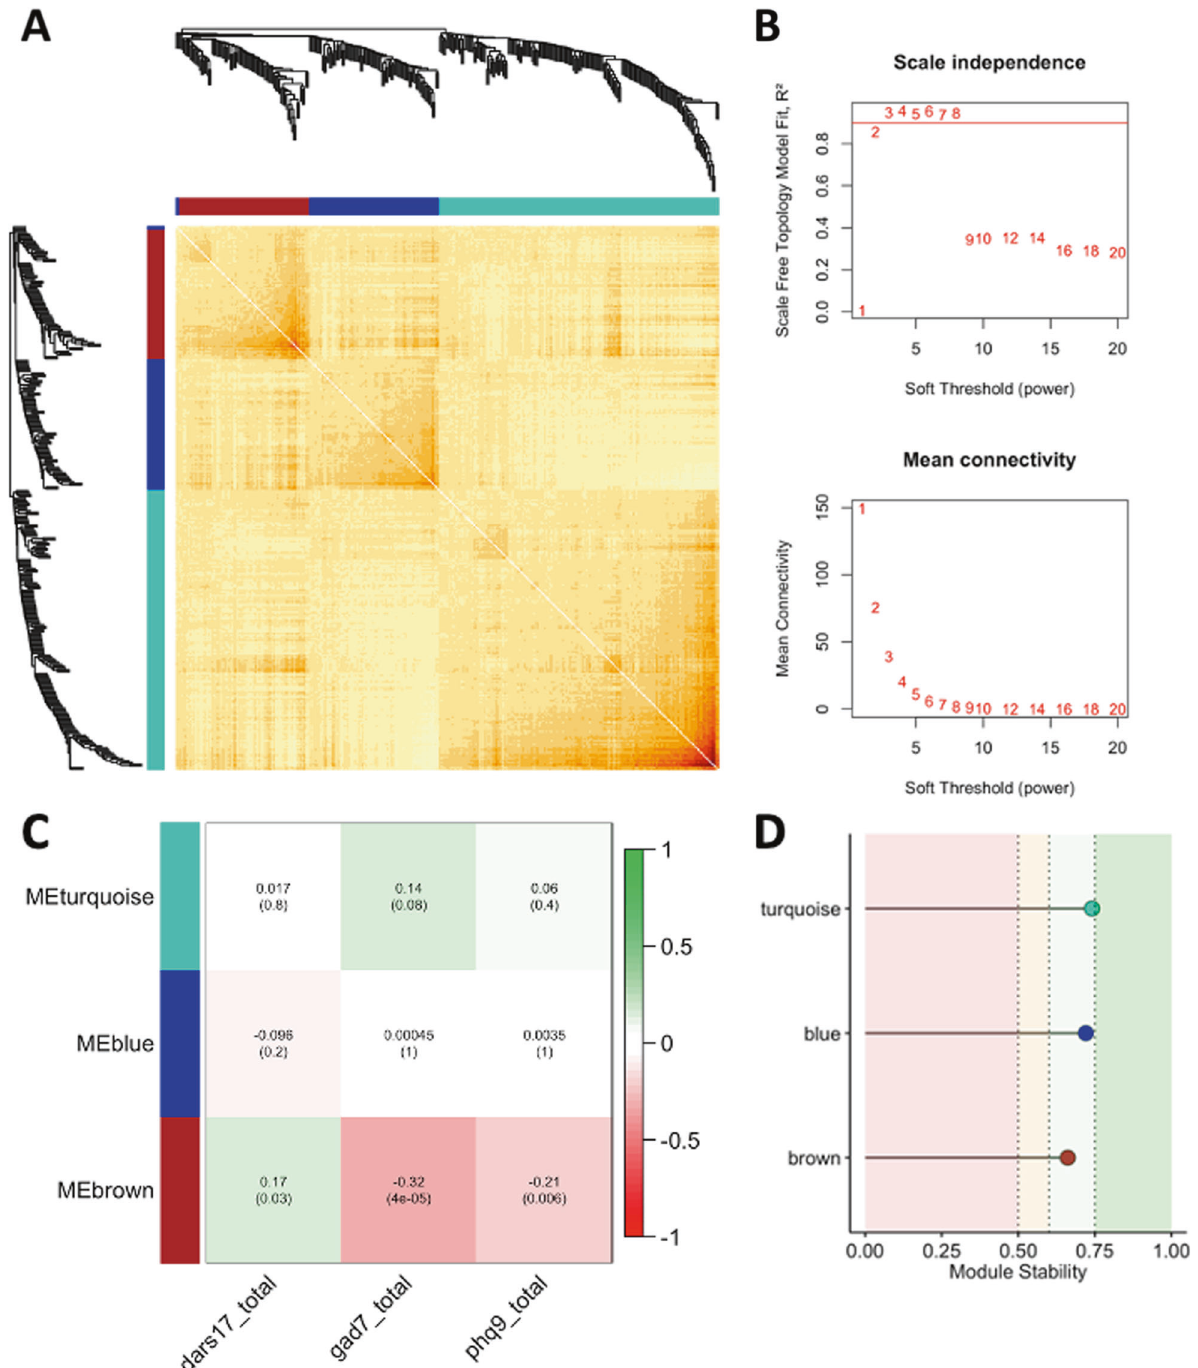
Fig. 2 Weighted taxon correlation network analysis reveals a gut microbial network associated with anxiety, depression, and anhedonia clinical test scores after BMI and age correction. The network was generated using minimum module size of 25. A Weighted correlation network soft-threshold parameter selection criteria graphs. B Weighted taxon correlation network visualized using dendrogram and heatmap of Topological Overlap Matrix. Our clinical study has three robust human gut microbial modules. C Correlation of gut microbial networks with clinical mood status. Abundance of taxa in the brown network are negatively correlated with clinical measures of anxiety, depression, and anhedonia. D The human gut microbial communities form valid modules. Module stability was calculated using the mean Jaccard similarity from one thousand bootstrapped module taxa and the original module